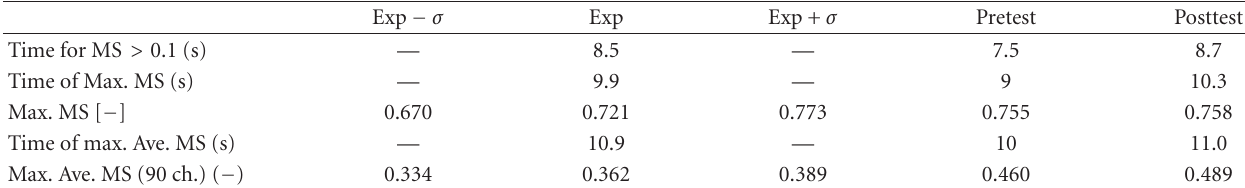
Table 2: Comparison of results (perturbation appearance; max. perturbation; core-average).